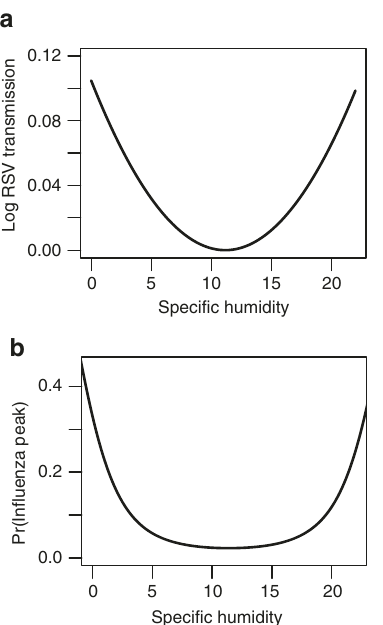
Fig. 4 Comparison with in fl uenza results. Removing precipitation from our regression model and including a quadratic humidity term reveals a very similar response ( a ) to earlier work on in fl uenza ( b adapted from Tamerius et al. 9 , Fig 3a) suggesting potential similar mechanisms underlie the climate effect on the two diseases. Predicted minimum transmission for RSV occurs at 11.16 g/kg, with in fl uenza found to be similarly 11 – 12 g/kg 9 . Tamerius et al. suggest precipitation may drive the right hand side of the humidity- in fl uenza curve, as we fi nd for